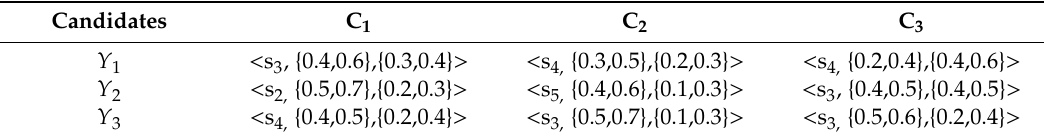
Table 3. Dual hesitant fuzzy linguistic stochastic decision matrix (under state H 2 ) H 2 ( p 2 = 0.4) . Candidates C 1 C 2 C 3 Y 1